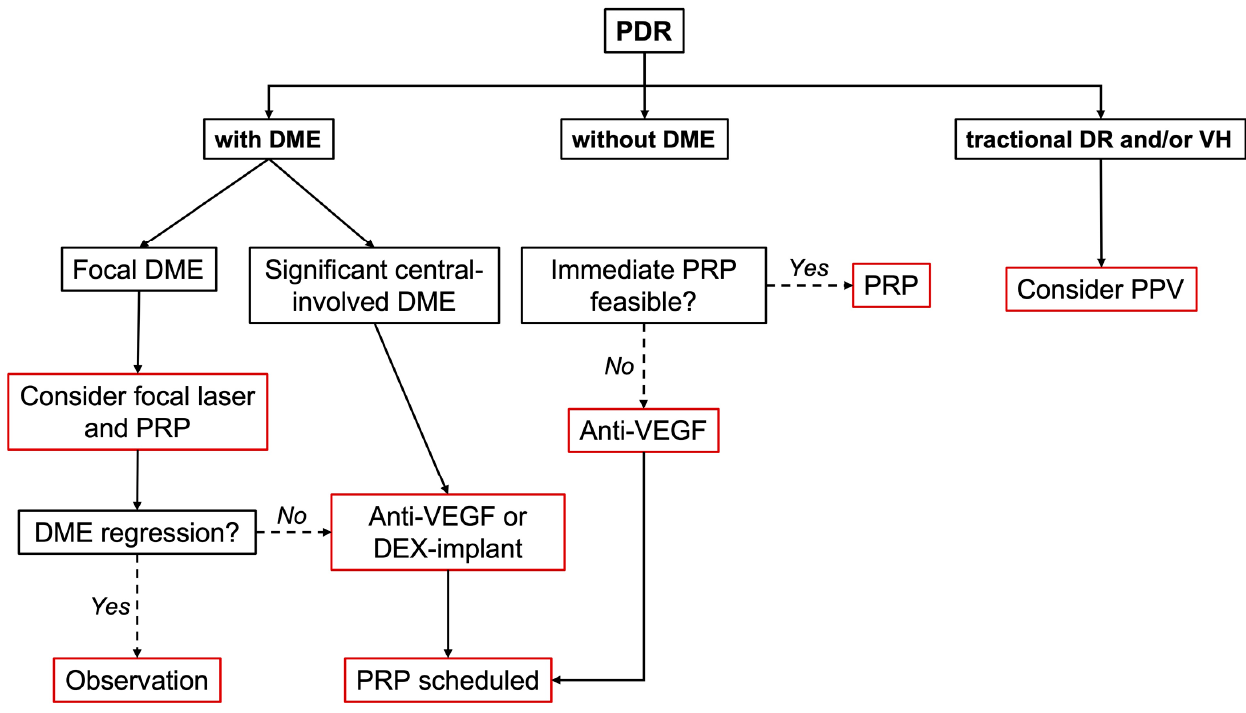
Figure 1. Treatment flow chart in different PDR scenarios. DEX-implant: dexamethasone implant; DME: diabetic macular edema; PDR: proliferative diabetic retinopathy; PPV: pars plana